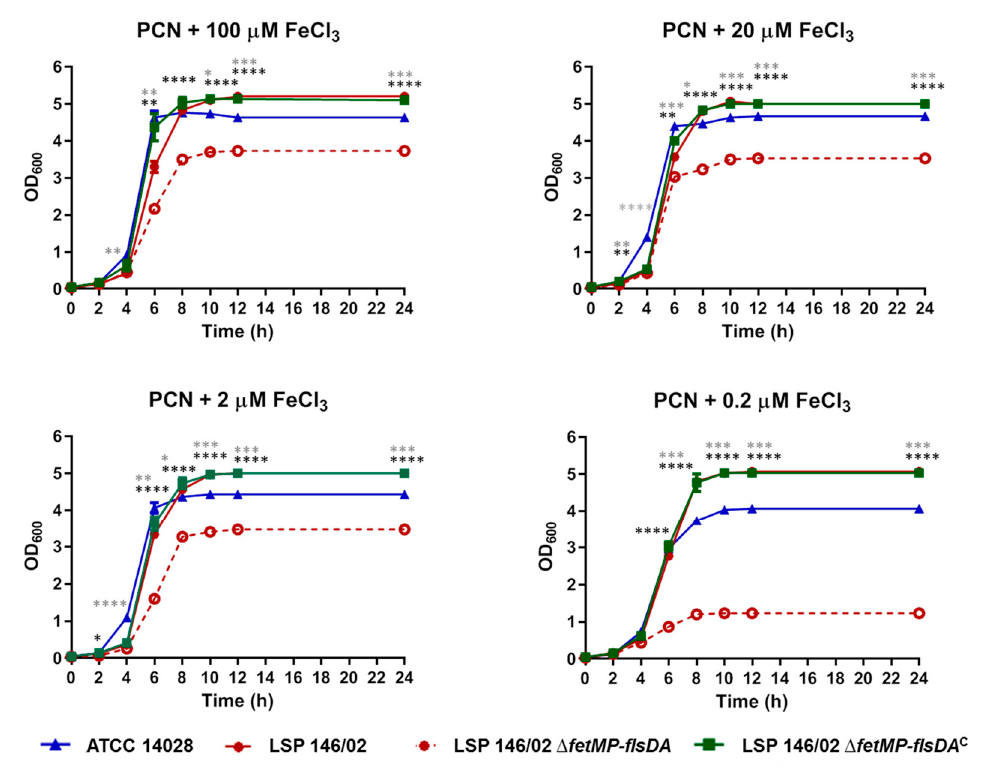
Figure 3. Growth curves obtained for S . Typhimurium ATCC 14028, S. Typhimurium LSP 146/02 wild-type, its isogenic Δ fetMP - flsDA derivative, and the complemented LSP 146/02 Δ fetMP - flsDA C strain using a PCN medium supplemented with decreasing concentrations of FeCl 3 . The data shown are the mean values ± standard deviations of three biological replicates. Statistical significance (**** p < 0.0001; *** p < 0.001; ** p < 0.01; * p < 0.05) was determined by ANOVA and the Tukey’s post-test. Black and grey asterisks show significant differences for LSP 146/02 versus Δ fetMP - flsDA and ATCC 14028, respectively. Significant differences were not observed for LSP 146/02 versus LSP 146/02 Δ fetMP - flsDA C .